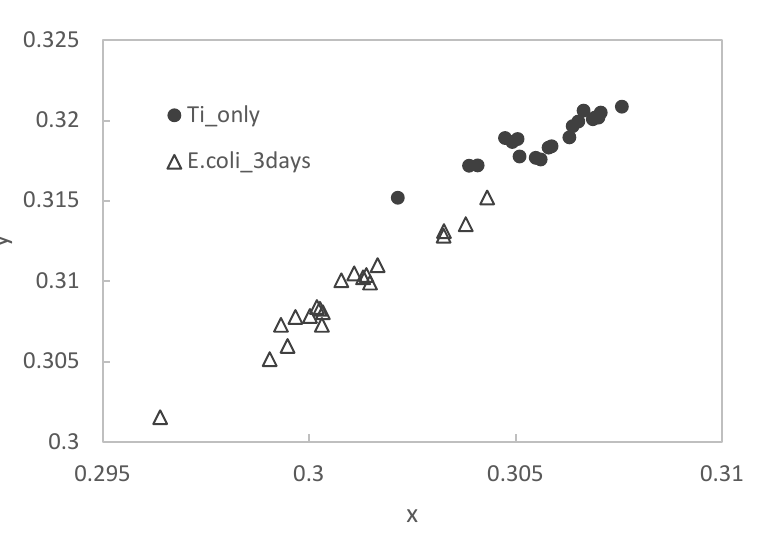
Table 3. Average values and their standard deviations based on image analyses and calculations. Average Standard Deviation